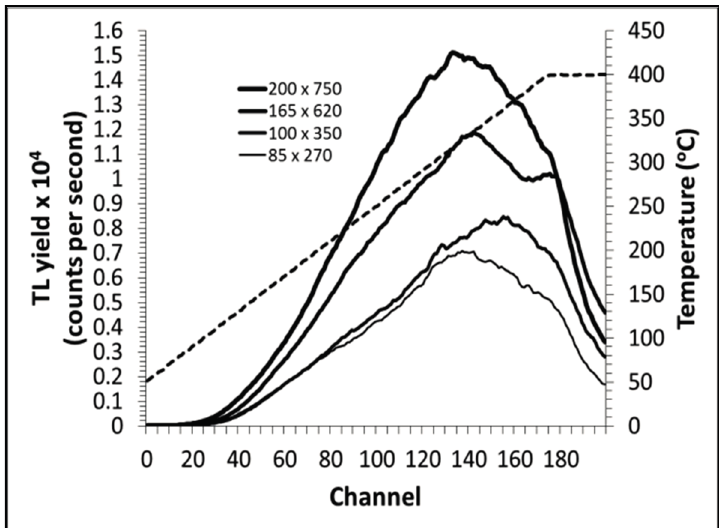
Figure 2. Typical fiber TL glow curves, all for a dose of 30 Gy delivered at Co-60 gamma-ray energies, encompassed between temperatures of ~200 °C and 370